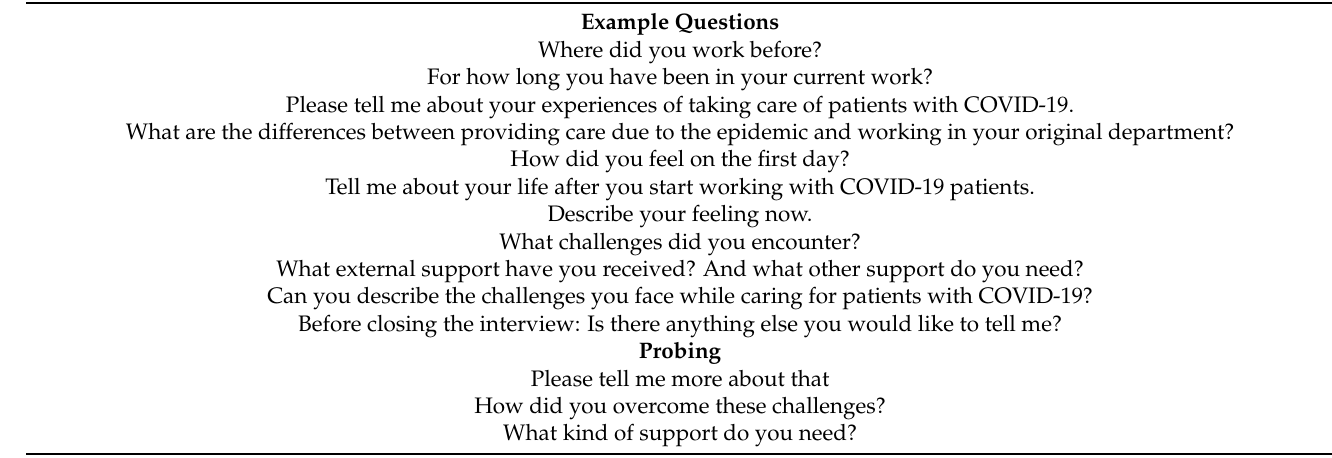
Table 1. Example questions and probing that were asked during the interview, based on reviewing relevant and related literature